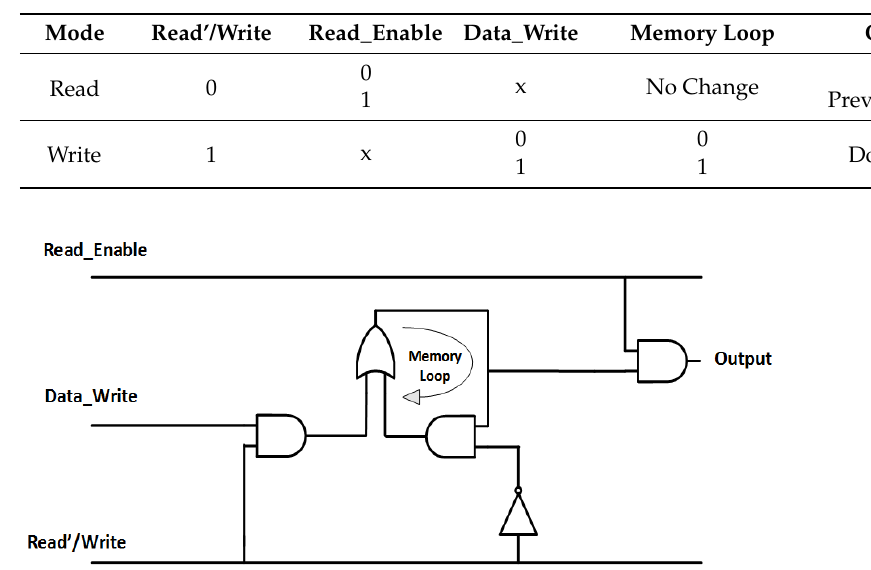
Table 1. Operation of Memory Cell.